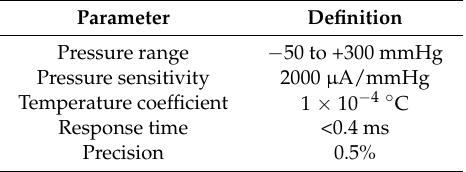
Table 1. Technique parameter summary of the HK-2000B pulse sensor.